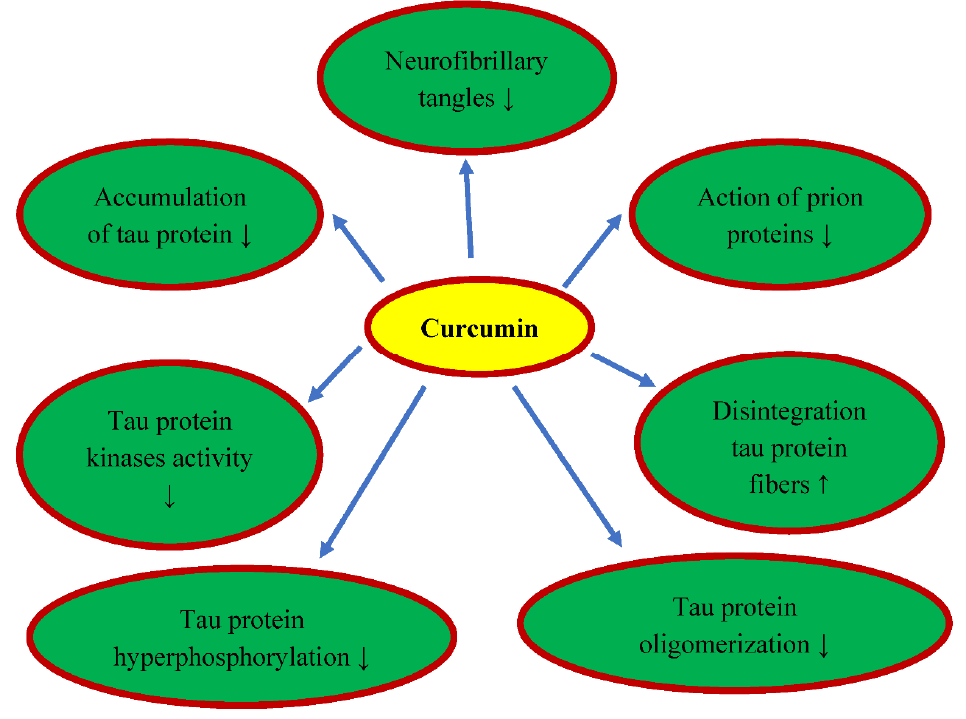
Figure 4. Protective effects of curcumin on post-ischemic tau protein dysfunction. ↓ —decrease, ↑